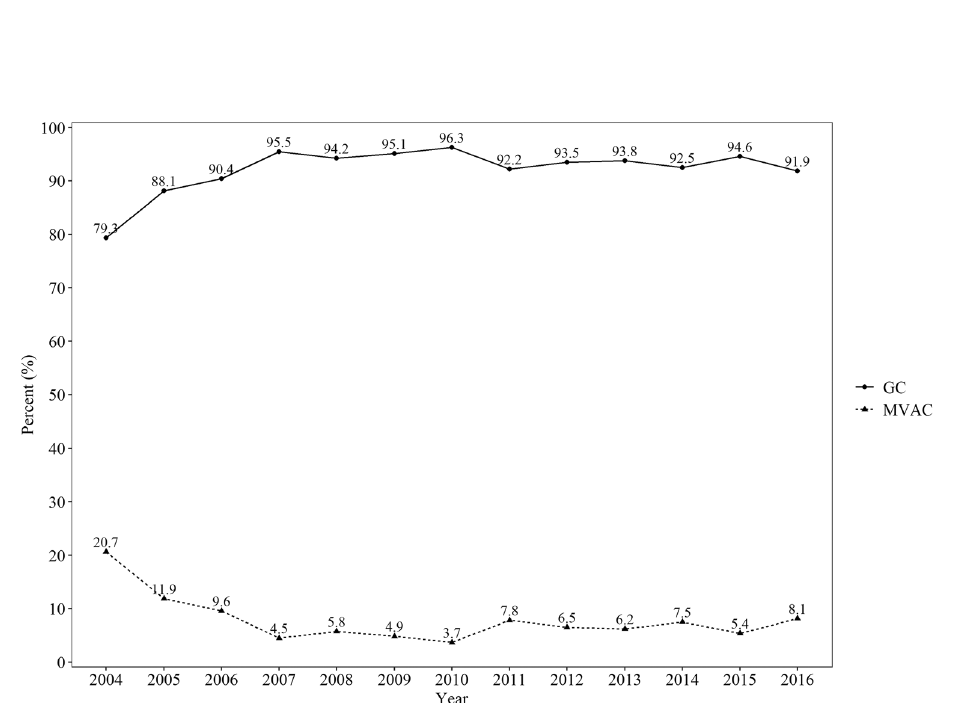
Figure 2. Upper tract urothelial carcinoma treatment